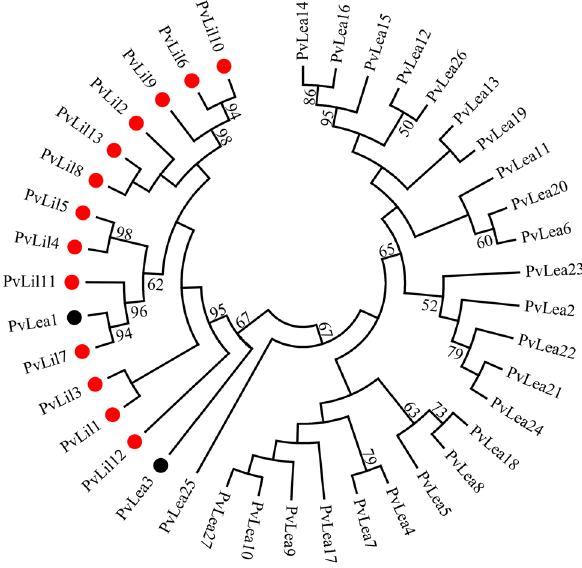
Figure 2. The phylogenetic tree of PvLil and PvLea genes.